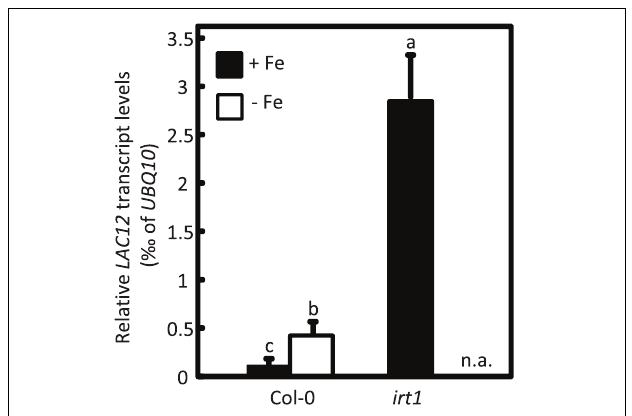
FIGURE 1 | LAC12 transcript levels increase under Fe deficiency. Relative LAC12 transcript levels in roots of wild-type (Col-0) and irt1 seedlings are analyzed by RT-qPCR. Seedlings were cultivated in standard Hoagland’s medium for 10 d (5 µ M FeHBED; unwashed agar) followed by a growth period of 5 d on Fe-sufficient (+Fe, 10 µ M FeHBED) and Fe-deficient (-Fe, 0 µ M FeHBED) agar-solidified Hoagland’s medium (EDTA-washed agar), on vertically oriented petri plates. Bars show arithmetic means ± SD of relative transcript levels normalized to UBQ10 , and were calculated from n = 3 technical replicates from one experiment representative of four independent biological experiments. n.a. not analyzed. Different characters denote statistically significant differences ( P < 0.05) between means based on ANOVA (Tukey’s HSD).